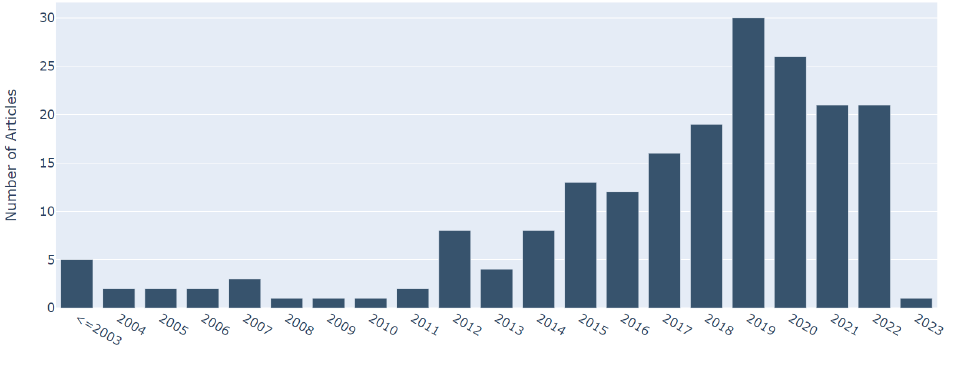
Figure 4. Yearwise distribution of the selected